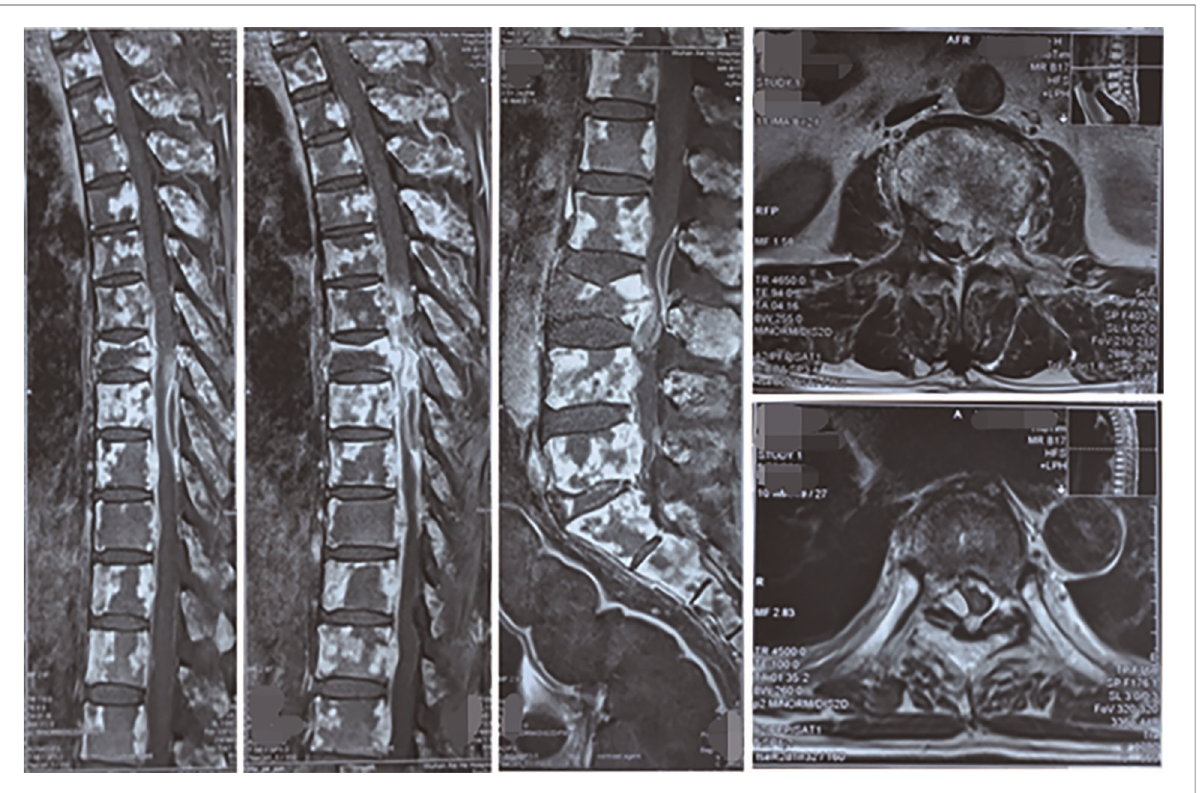
FIGURE 3 MRI images of vertebral bone metastases and spinal cord compression in primary lung